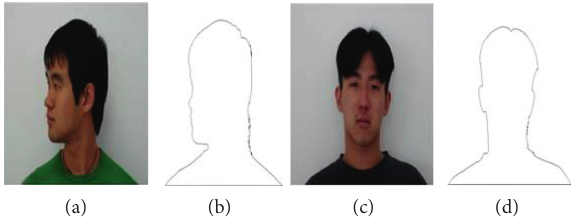
Figure 4: The original image (a), (c) and the filtered image (b), (d) by the laplacian process.